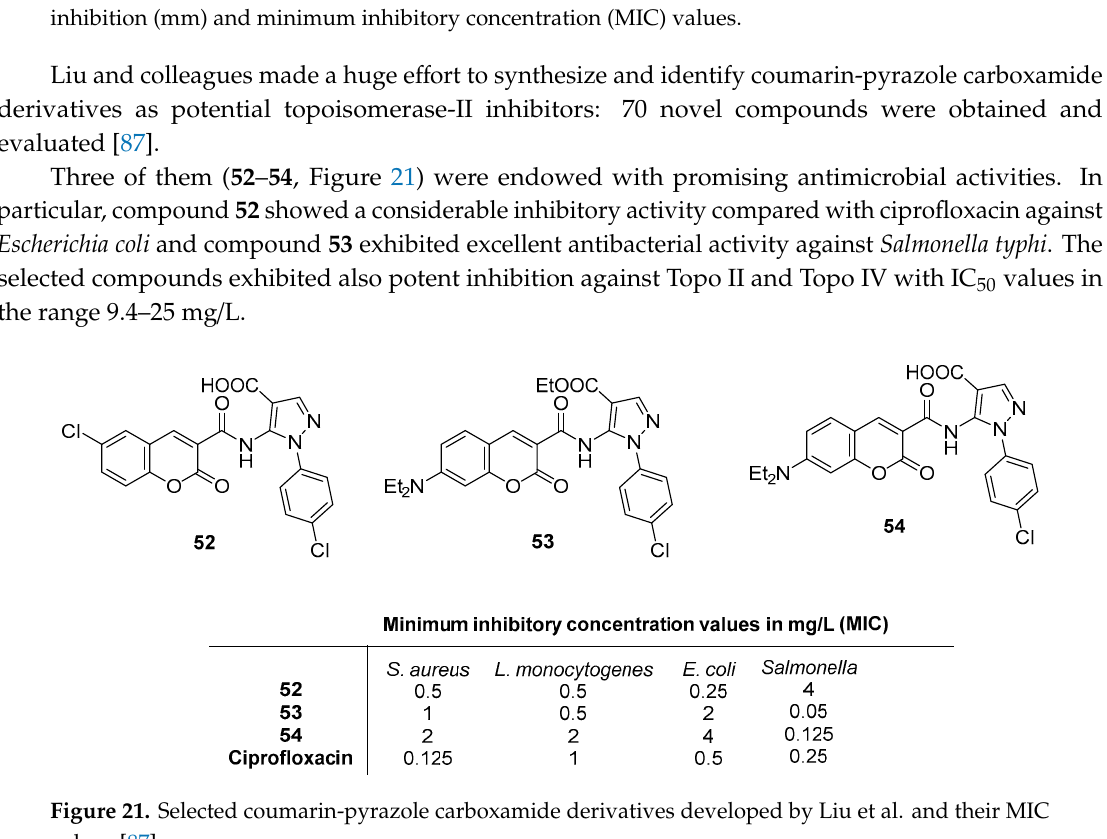
Figure 20. Linear coumarins isolated from the fruits of Peucedanum luxurians Tamamsch, zone of inhibition (mm) and minimum inhibitory concentration (MIC) values.